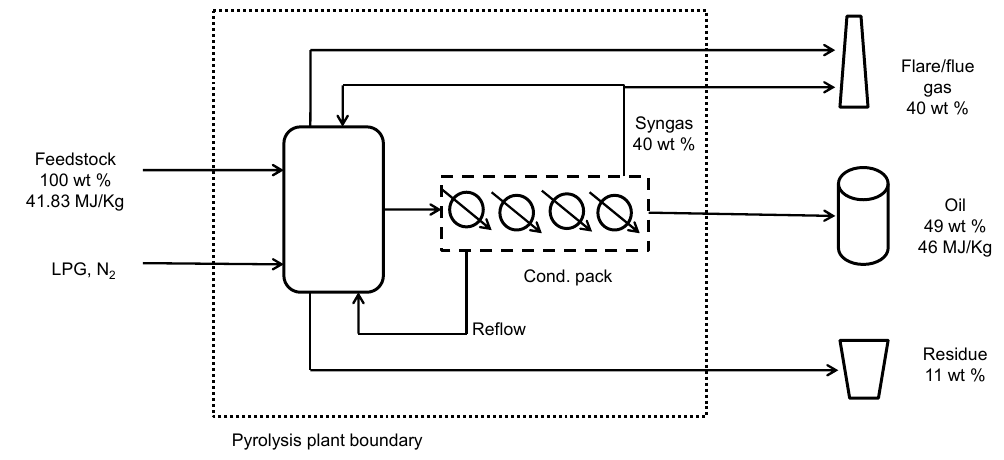
Figure 2. Mass and energy balance of the pyrolysis plant.